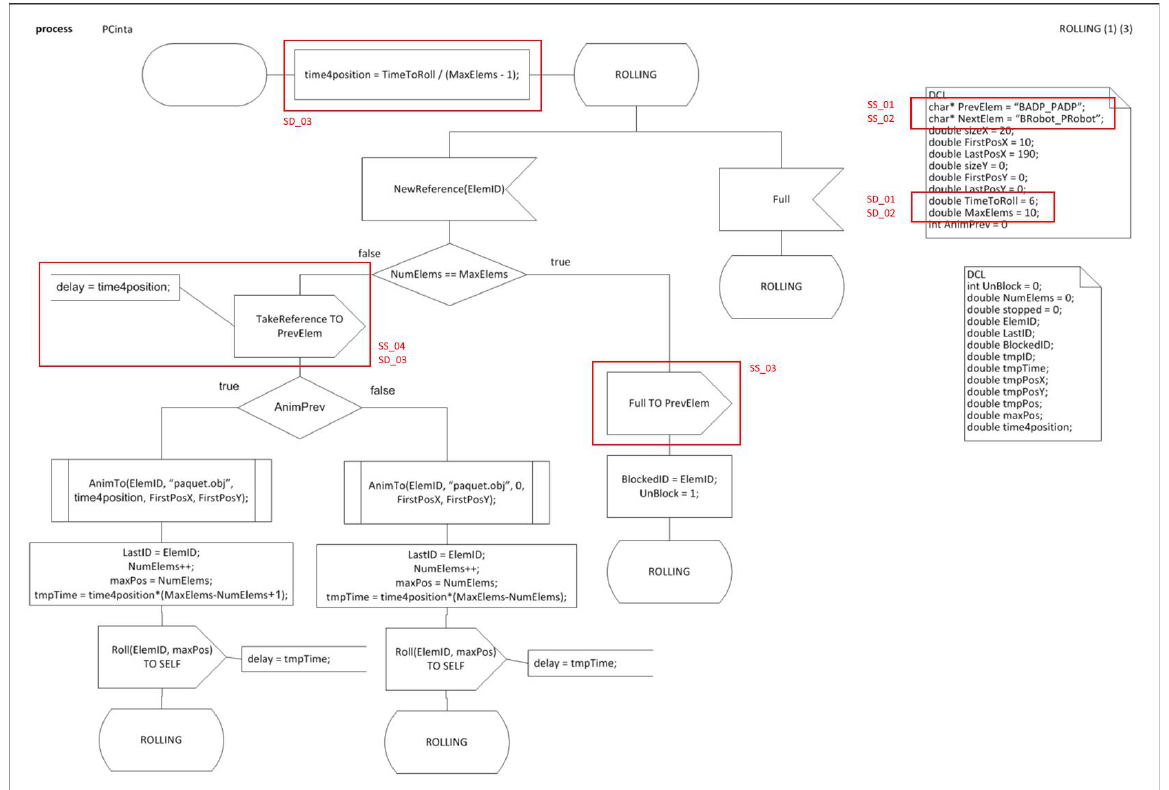
Figure 2. PCinta for the ROLLING state (1/3). Here is presented the PROCESS instantiation. The time4position variable is a Systemic Data assumption that defines the movement of the elements on the conveyor. It states that the time needed to arrive at a specific position depends on the TimeToRoll (defined as 6 s to cross the conveyor) and the number of positions of this conveyor (defined in MaxElems as 10). This Specification and Description Language diagram details unambiguously and completely the assumptions of the model. However, like any conceptual model, it is not going to depict the simplification assumptions used. Table 5. Assumptions table. The TimeToRoll variable is not yet validated on this iteration; hence all the assumptions that are related to it are considered valid but not true. In this iteration, we also detect that the maximum number of elements that can be on a conveyor is not 10; hence SD_02 is false; we must go to the factory and measure the new number of elements that can be on the con- veyor.